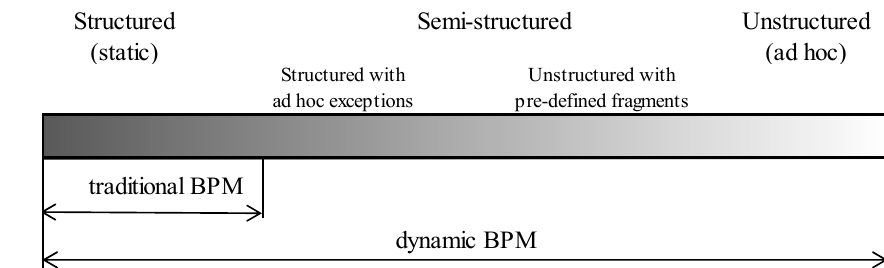
Figure 1. The degree of business processes structurization. Source: Authors’ own framework, on the basis of [12,27,31]. BPM: business process management.